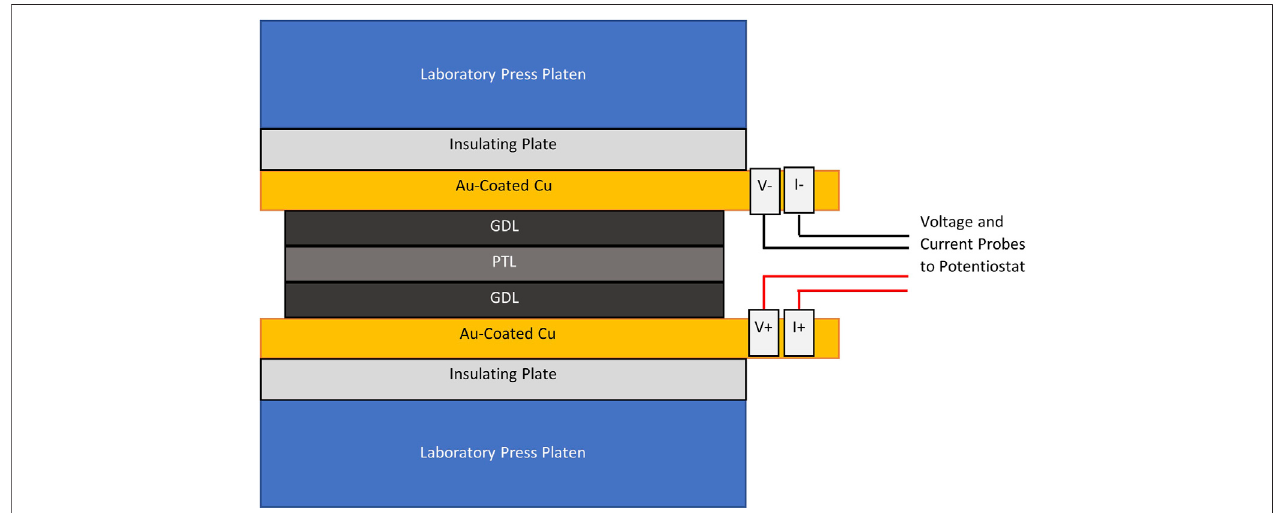
FIGURE 1 | Test setup for the PTL resistance